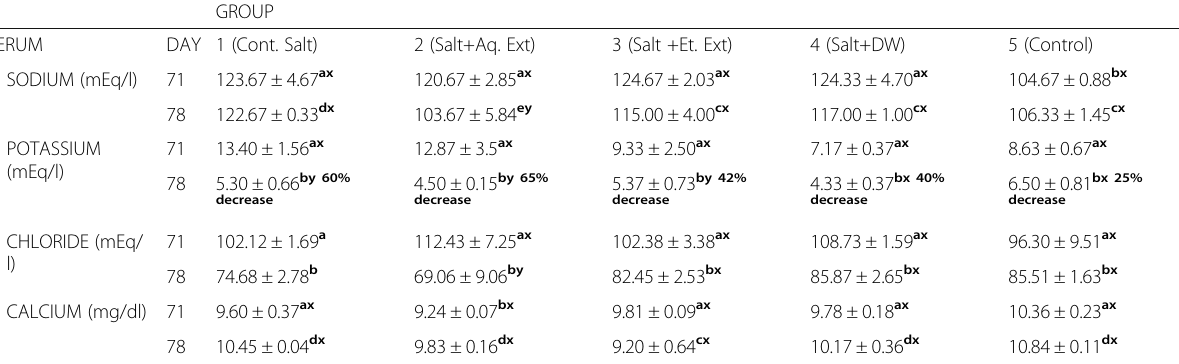
Table 1 The effects of oral administration of extracts (aqueous or ethanol) of A. wilkesiana leaves on serum sodium, potassium, chloride and calcium concentrations of salt-loaded rabbits GROUP